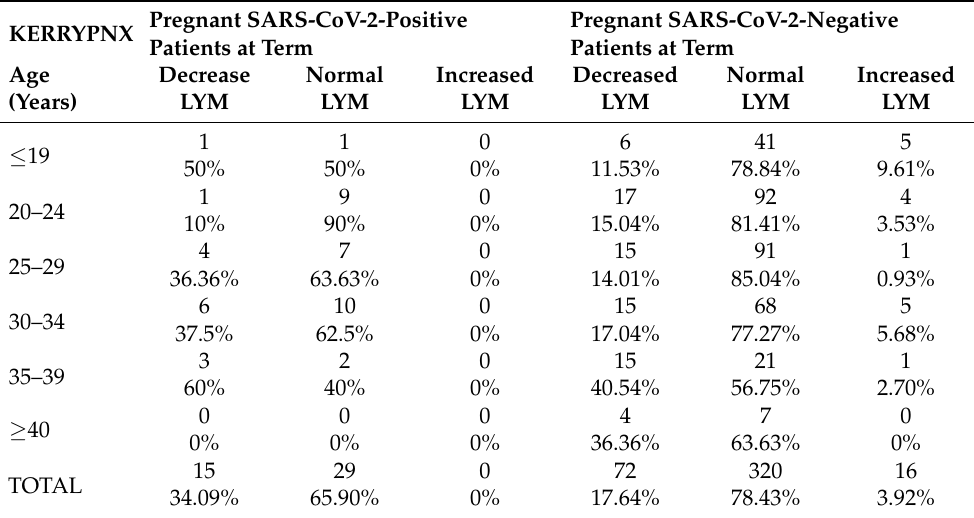
(Table 7), and parity number (Table 8). The one lymphopenia patient was included in these tables in the “decreased LYM” category of patients. Table 6. Number and percentage of pregnant patients with a normal, increased, and decreased number of lymphocytes in regards to age.